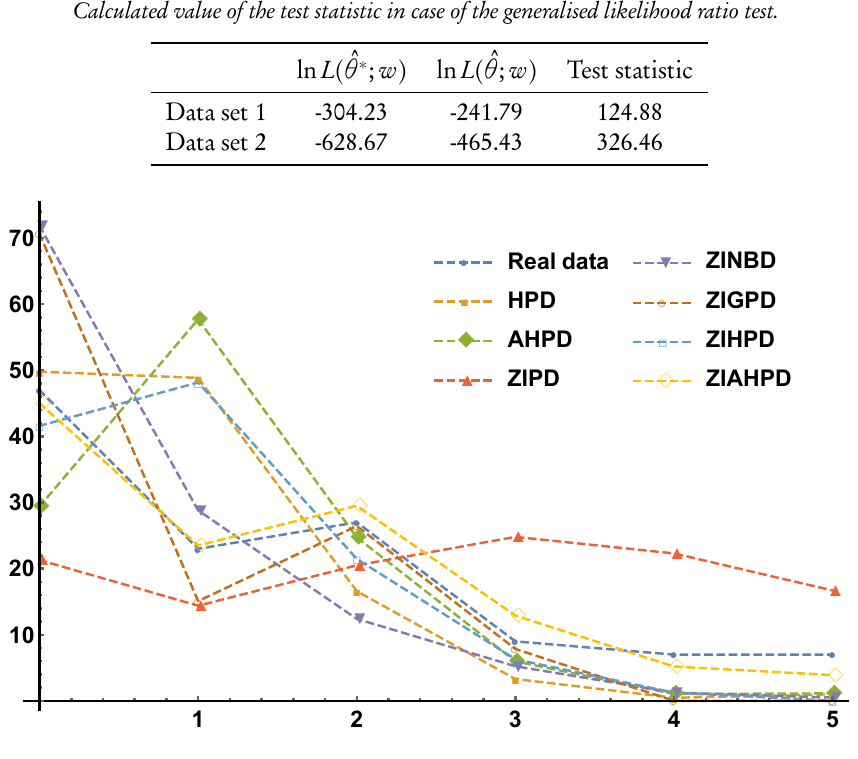
Figure 9 – Frequency curves corresponding to data set